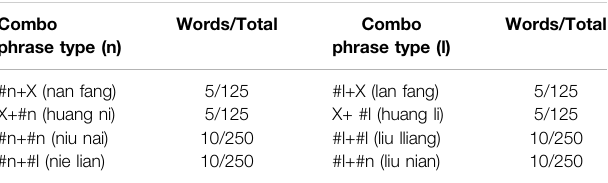
TABLE 4 | Standard Mandarin disyllabic words list numbers for initial /l/ and /n/